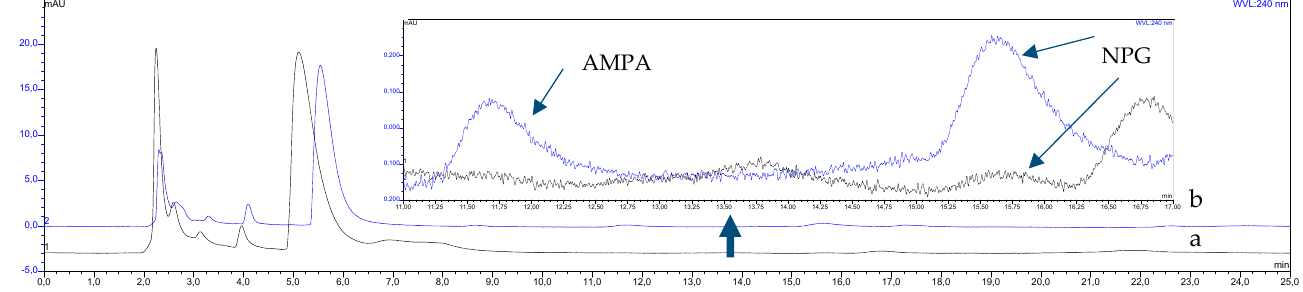
Figure 5. Chromatograms obtained from the analysis of UAE—SLM extracts of barley groats samples: ( a )—blank sample and ( b )—fortified extract (SLM conditions—donor: 100 mL of extract at pH = 11, acceptor: 5 mL 2 M NaCl, membrane phase: 20% Aliquat 336 in DHE, flow rate of donor and acceptor phases: 0.2 mL/min, extraction time: 24 h).